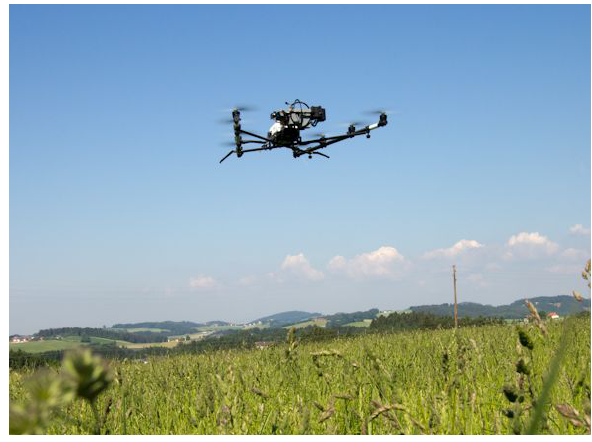
Figure 3: flying Game Guard in action